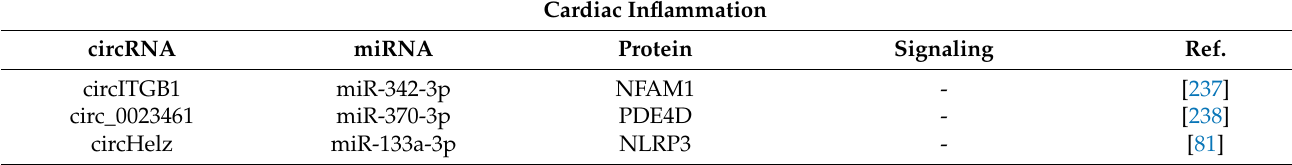
Table 2. List of circRNAs and their corresponding sponged microRNAs that, accordingly, affect the expression of distinct proteins and signaling pathways. circRNAs and proteins that are highlighted (in bold) correspond to those circRNAs and proteins that have been reported to physically interact with each other, i.e., by means of pull-down assays.